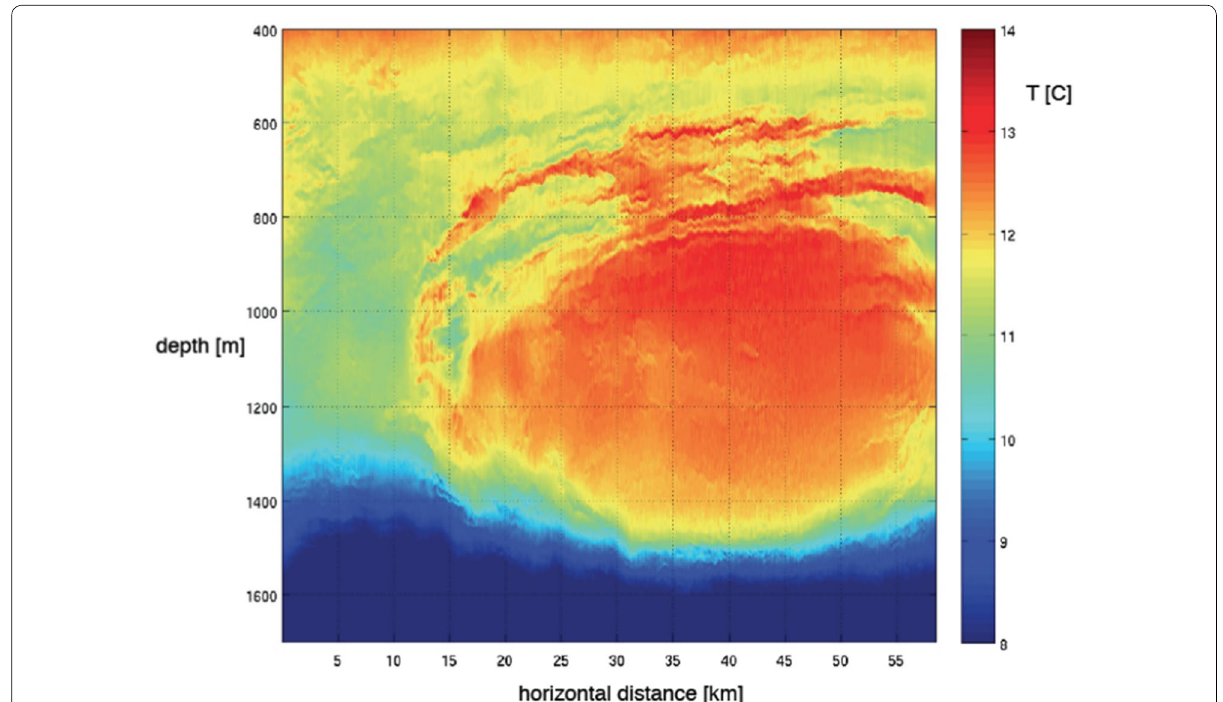
Fig. 14 Meddy SCV. An acoustic tomographic image of a cross section of T in a Mediterranean eddy (Meddy) offshore in the Eastern Atlantic (Papenberg et al. 2010). It is formed by an instability of the separating Iberian slope current fed by the Mediterranean outflow. Lifetimes are up to years, and a few are known to traverse the width of the Atlantic ocean